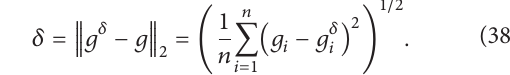
Figure 6: Comparison between the exact solution and its computed approximations with 𝑘 = 1 and various noise levels of 𝜀 = 0.1 , 𝜀 = 0.01 , 𝜀 = 0.001 for Example 6.